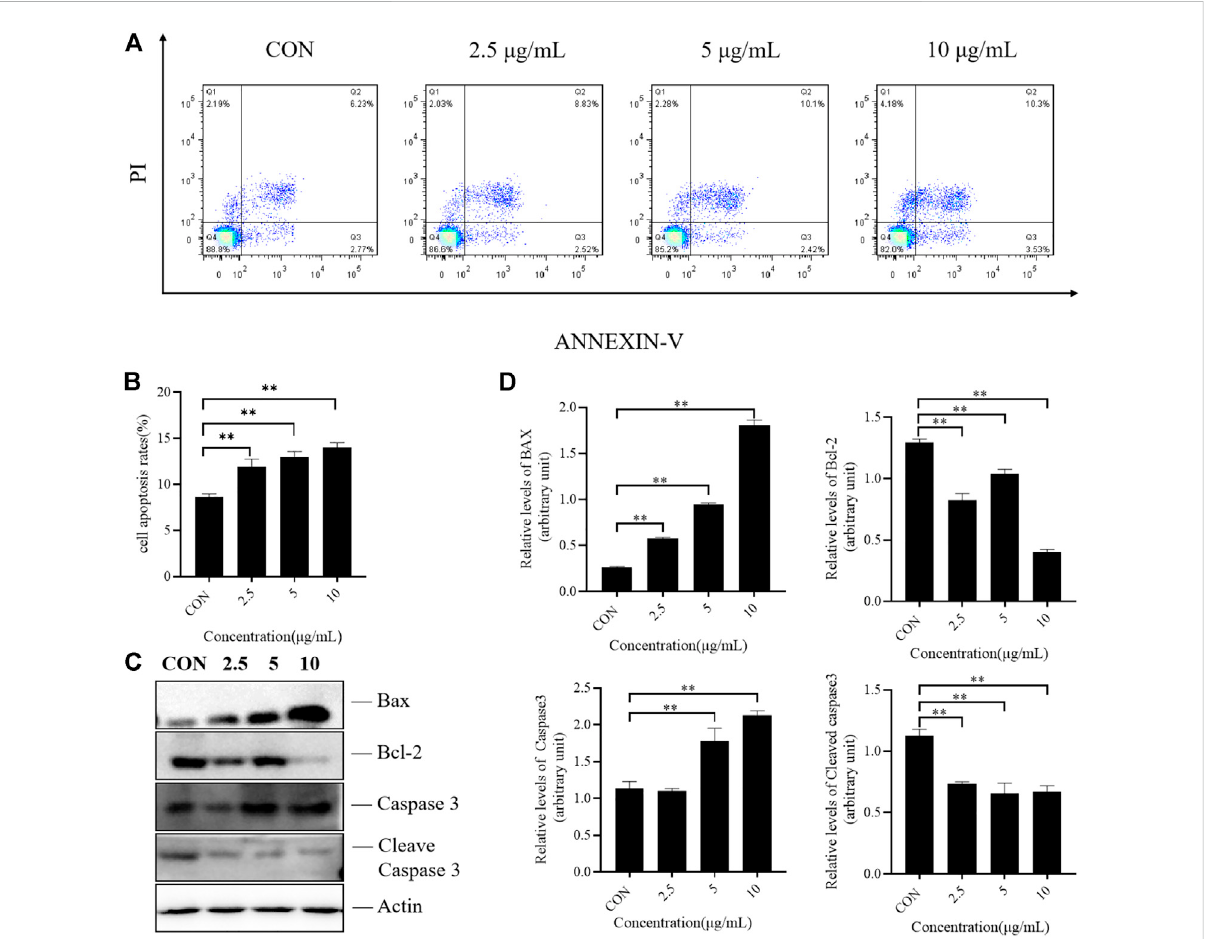
Effects of TTH on the apoptosis of H1975. (A) H1975 cells were treated with TTH at 2.5 µg/ml, 5 µg/mL and 10 µg/ml for 48 h and cell apoptosis was analyzed by fl ow cytometry; (B) Histogram summarized the results of (A) . The activity of H1975 was evaluated by Annexin-V/PI staining; (C) Western blot showed the protein level of caspase-3, cleaved caspase-3, Bax and Bcl-2 following the total Triterpenoids treatment for 48 h. Actin served as an equal loading control; (D) Histogram summarized the results of (C) . Error bars represent means ± SEM of n = 3. ** p < 0.01 vs. control